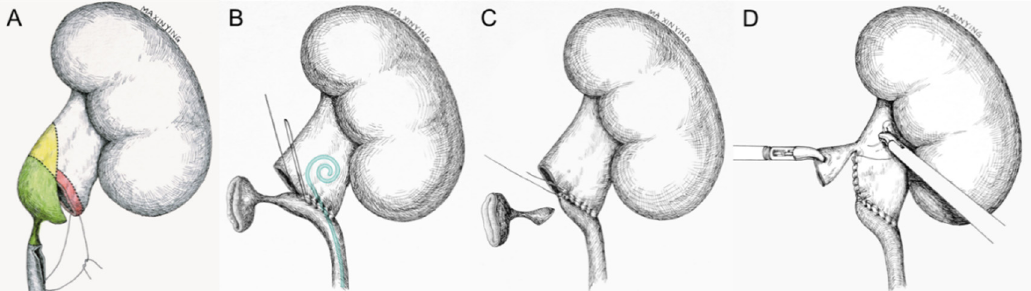
Figure 4. The diagram of modified dismembered pyeloplasty. ( A ) The first stitch is taken between the ureter and the lowest corner of the renal pelvis (the red color representing the area of anastomosis); ( B ) after clipping the connection of the UPJ with the renal pelvis, the anastomosis was performed by running suture starting from the point of first stitch, and then a 7F double-J stent was inserted into the distal ureter; ( C ) the strictured segment of the ureteropelvic junction was removed; ( D ) the redundant renal pelvis was sheared while the margin is continuously sutured, and finally a modified dismembered pyeloplasty was completed.